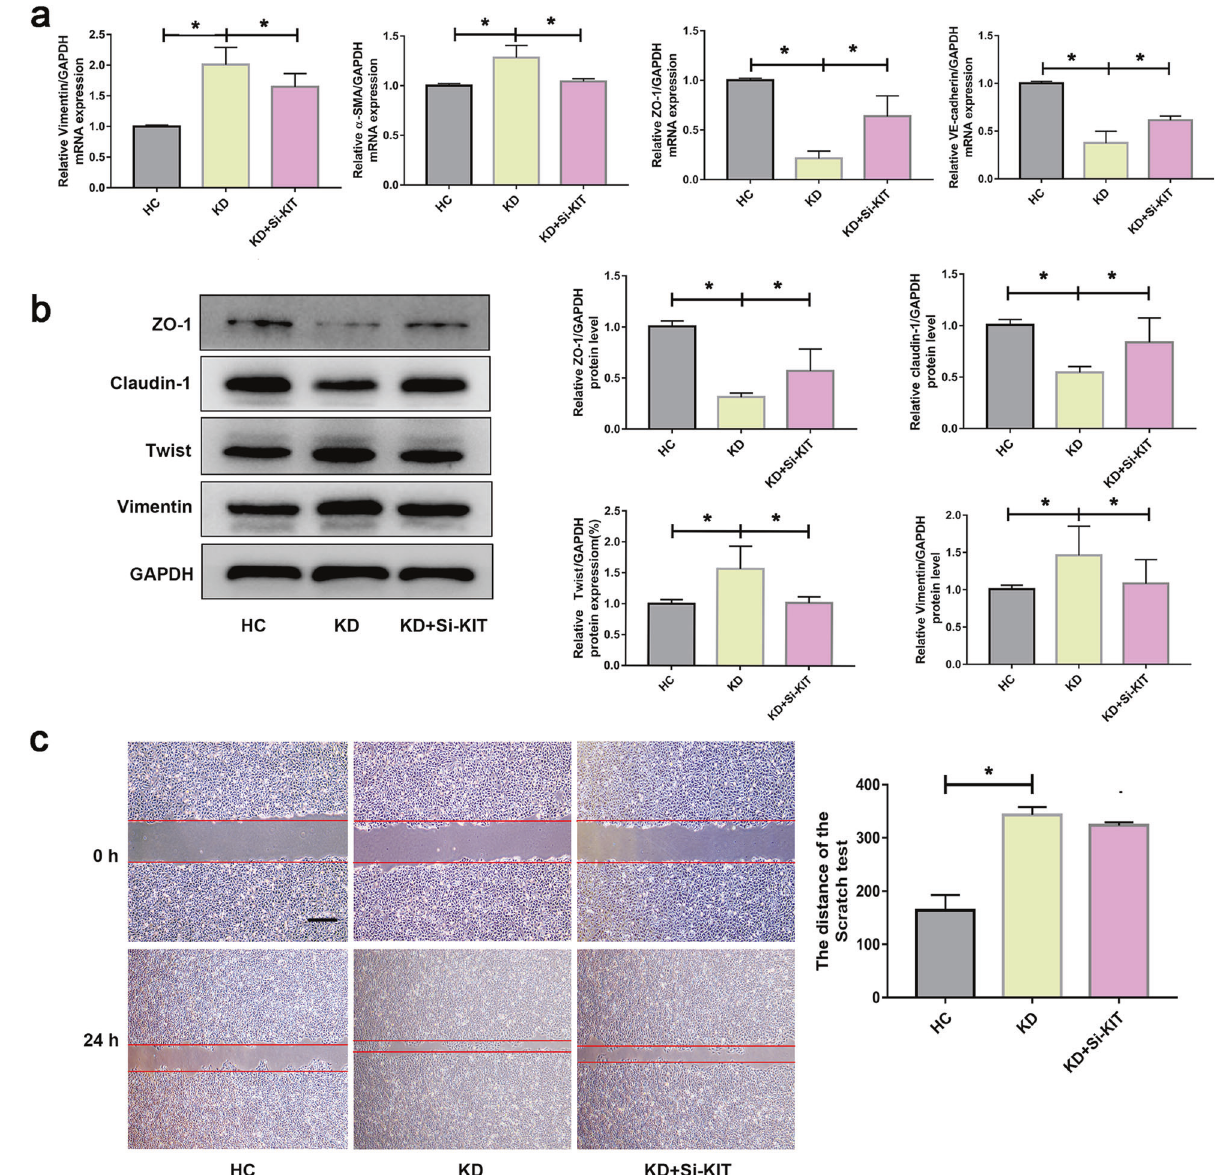
Fig. 6 Knowing down of KIT alleviates KD serum-mediated EndMT process. a HUVECs were transfected with si-KIT, and then treated with medium containing 15% sera from HC ( n = 6) and KD subjects ( n = 6) for 48 h. After that, the mRNA levels of Vimentin, α -SMA, ZO-1, and VE- cadherin were examined by RT-qPCR analysis. b The protein levels of ZO-1, Claudin-1, Twist, and Vimentin were determined by Western blotting. c Migration ability was analyzed by scratch assay (n = 3) Magni fi cation:×40 and scale bar = 100 μ m for scratch assay. Data were shown as mean ± SD, and * P < 0.05 vs. the HC group or KD